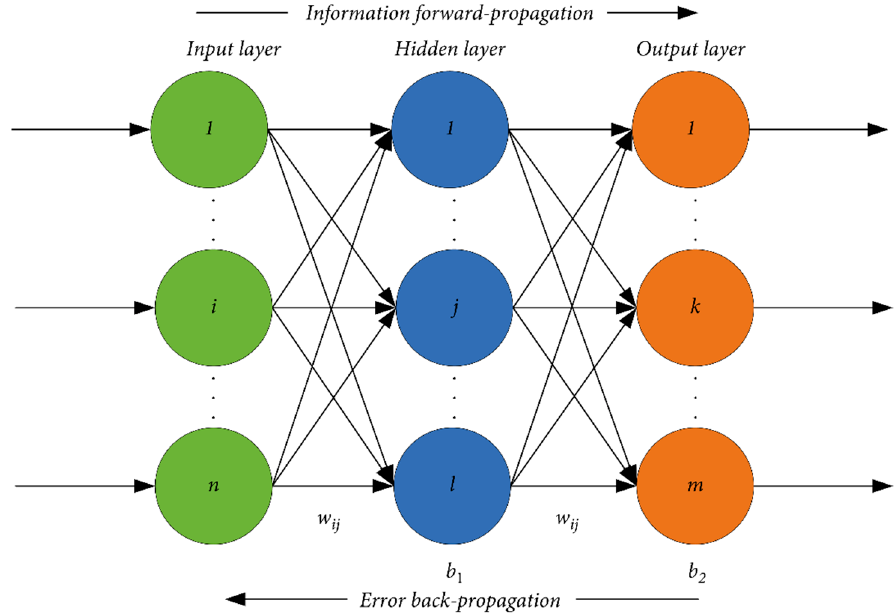
Figure 11. Back propagation neural network structure diagram in 2022 [91].